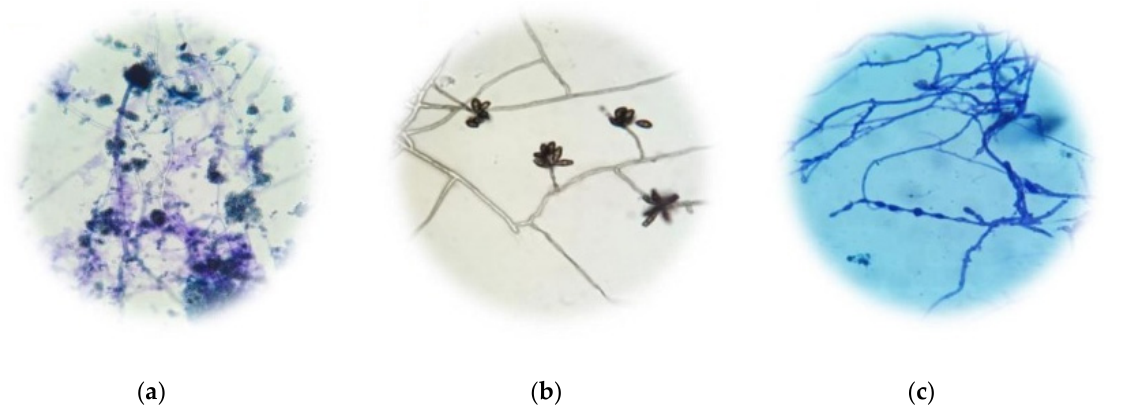
Figure 4. Morphology of the types of molds detected in paper made from Krajood. Aspergillus sp. ( a ), Curvularia sp. ( b ), and Cladosporium sp. ( c ).